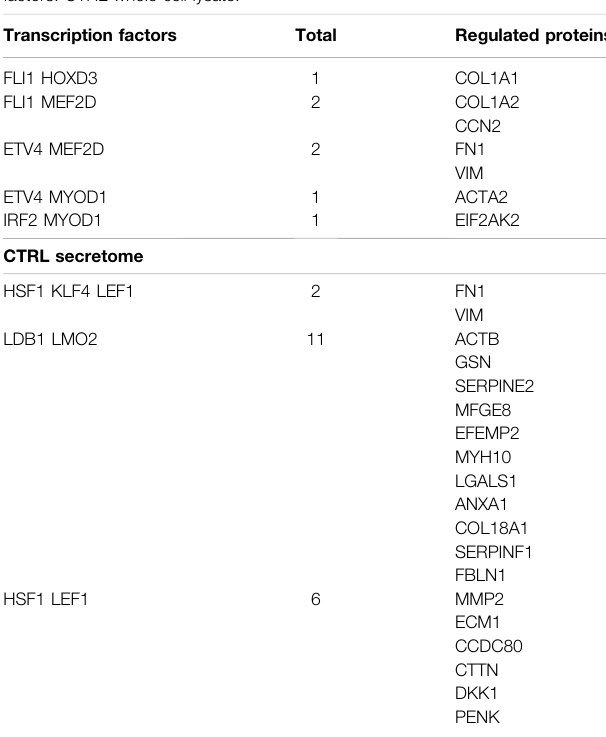
TABLE 4 | Proteins in the metformin-treated datasets and the related upstream transcription factors. Metfomin whole cell